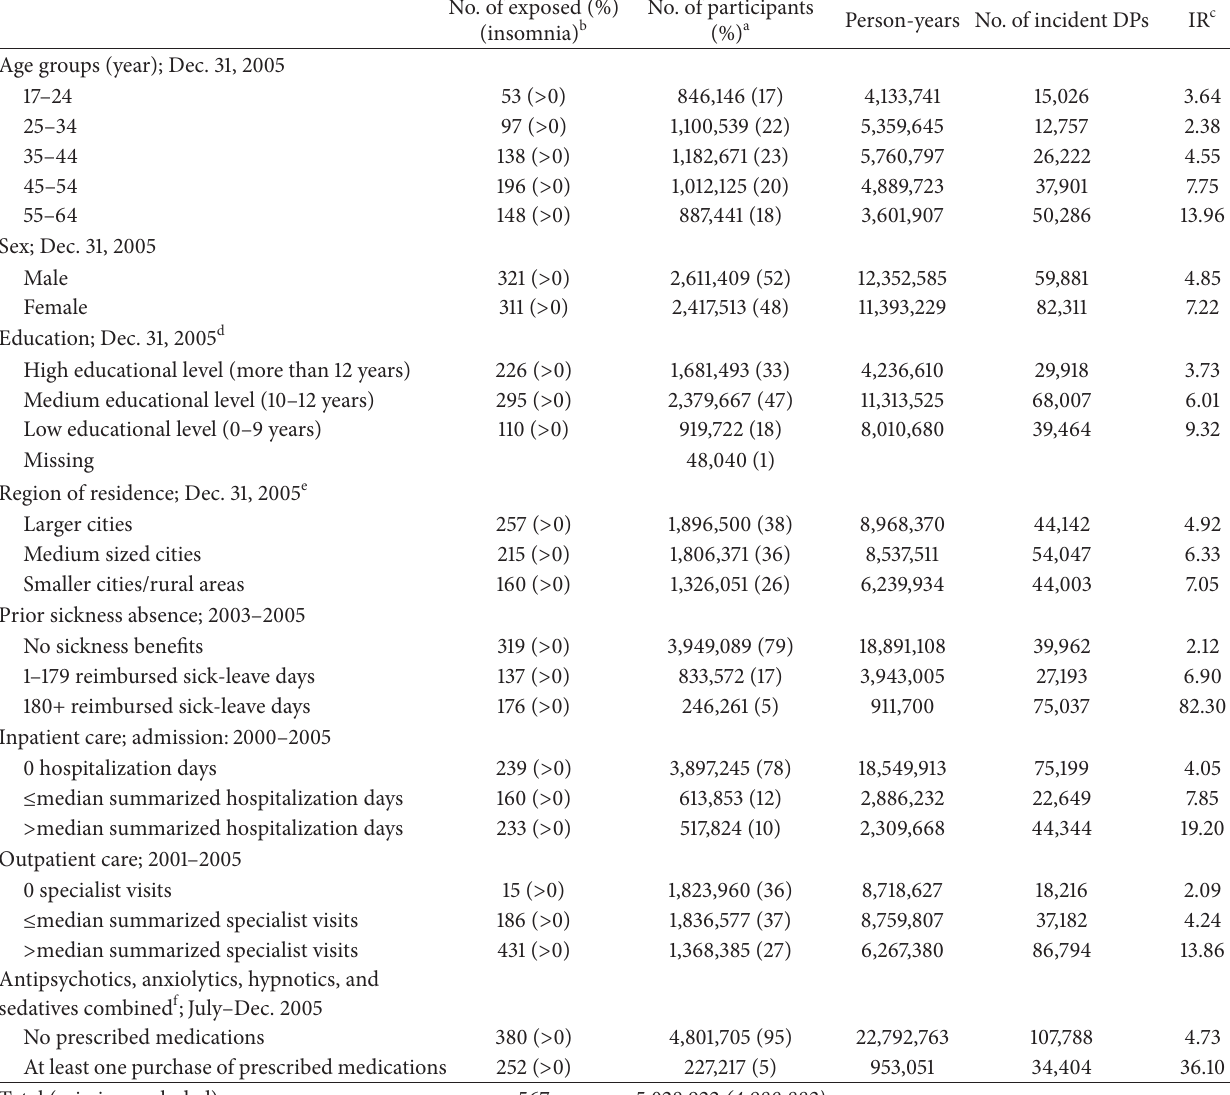
Table 1: Number of participants, person-years, all incident disability pensions (DPs), and incidence rates (IRs) by the adjusted